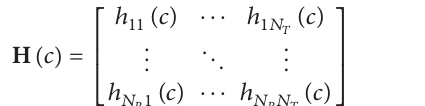
is a diagonal matrix containing the singular values of H